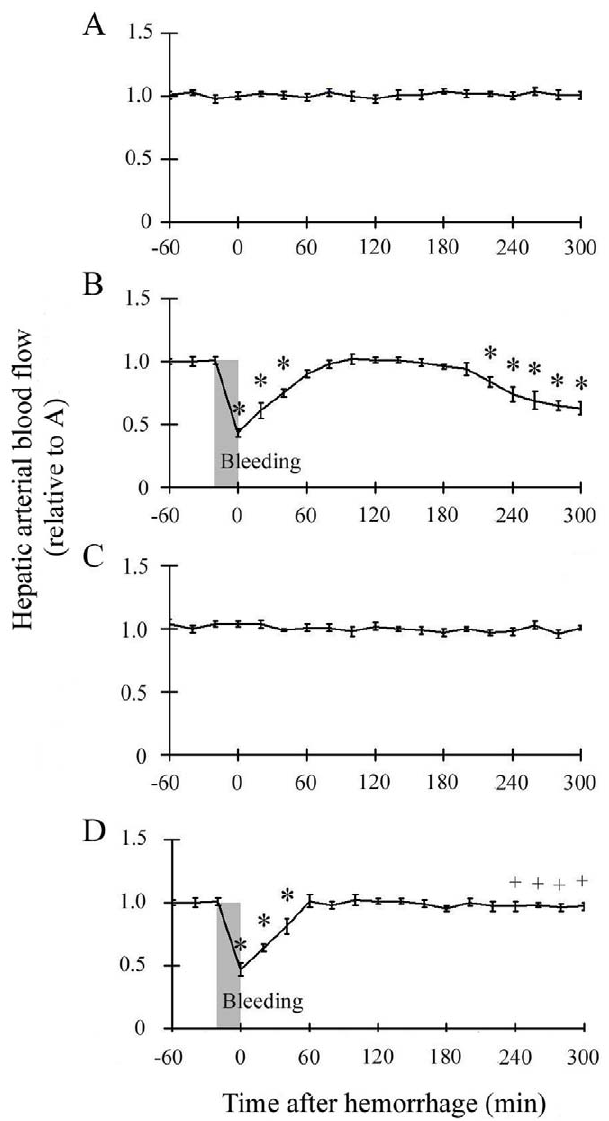
Figure 2. Time course of hepatic arterial blood flow (HBF). The abbreviations are the same as those in Fig. 1. The change in HBF was similar to that in MBP. Data are shown as mean 6 SE. n=5/groups, * p , 0.05 vs Sham, + p , 0.05 between Hemorrhage and FR + Hemor- rhage.